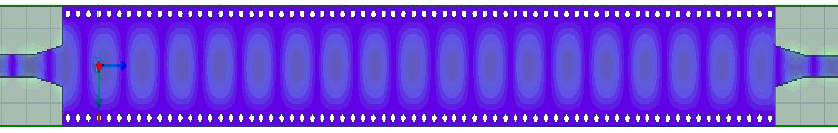
Figure 4. Electric field distribution for the SIW.